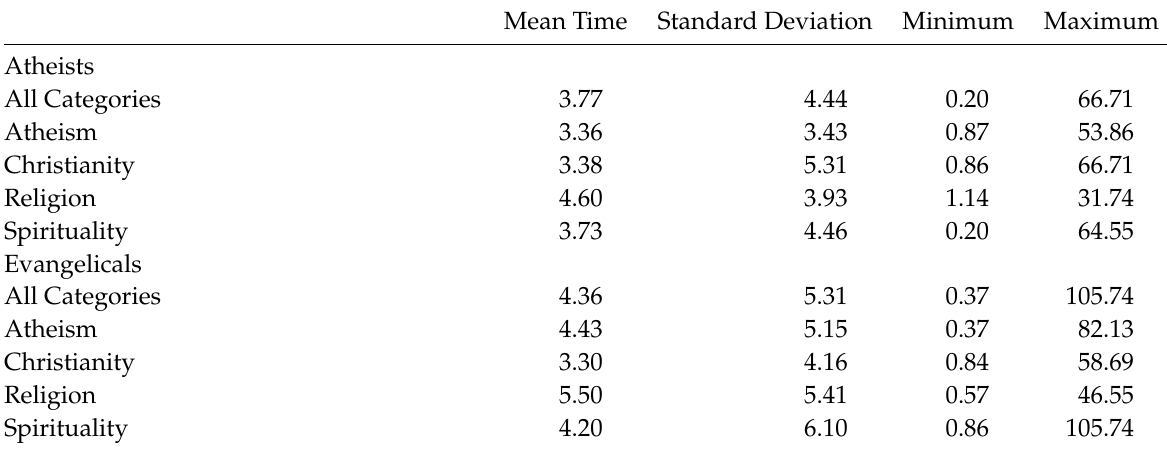
Table 2: Descriptive statistics for response latencies in seconds (all respondents